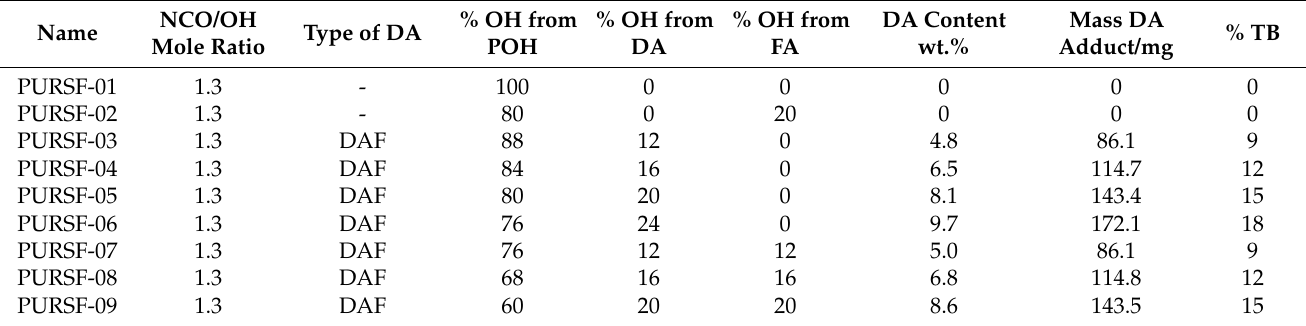
Table 3. Solvent-free adhesives’ nomenclature and